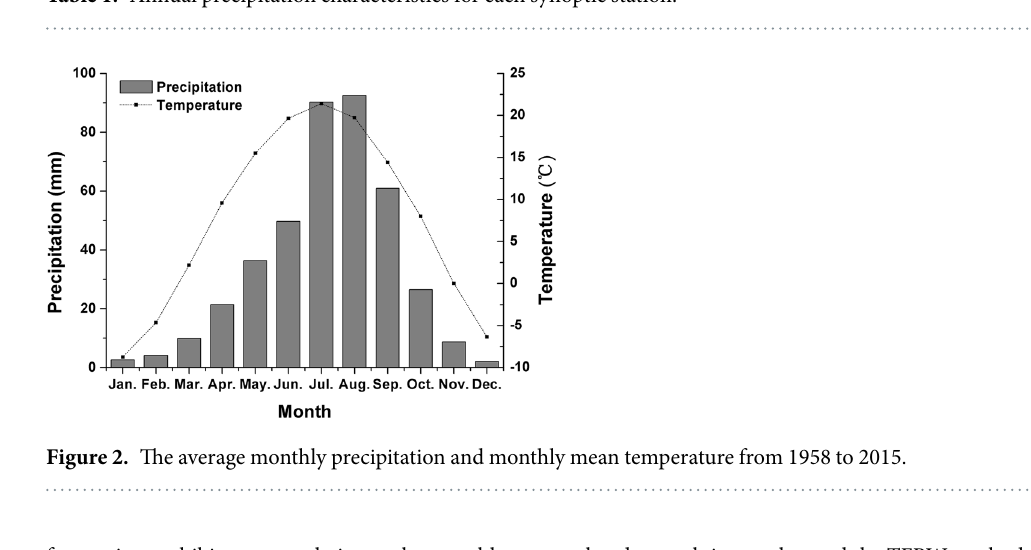
Table 1. Annual precipitation characteristics for each synoptic station.